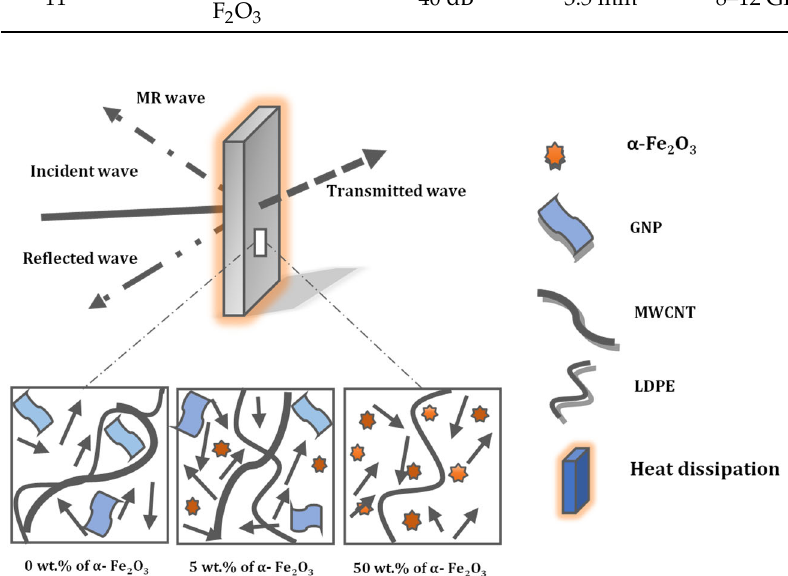
Figure 14. Schematic diagram of composite with various LDPE: MWCNT: GNP: α -Fe 2 O 3 fillers ma ‐ trix.